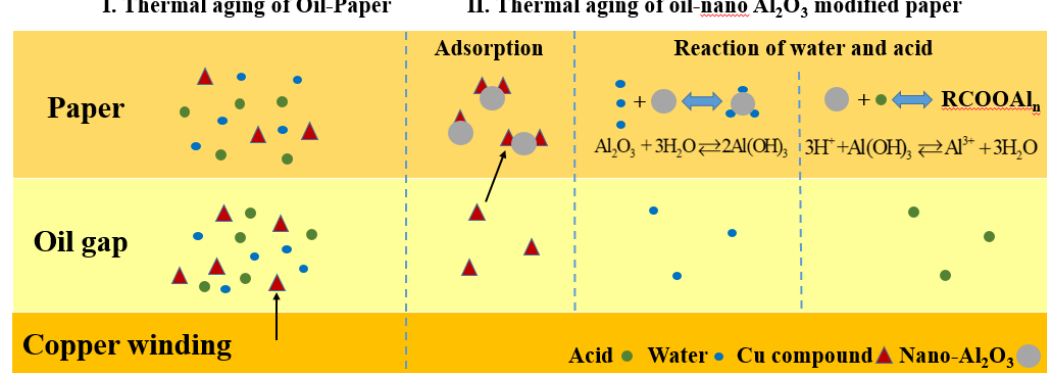
Figure 11. Influence of nano-Al 2 O 3 on thermal aging of insulating paper and oil .